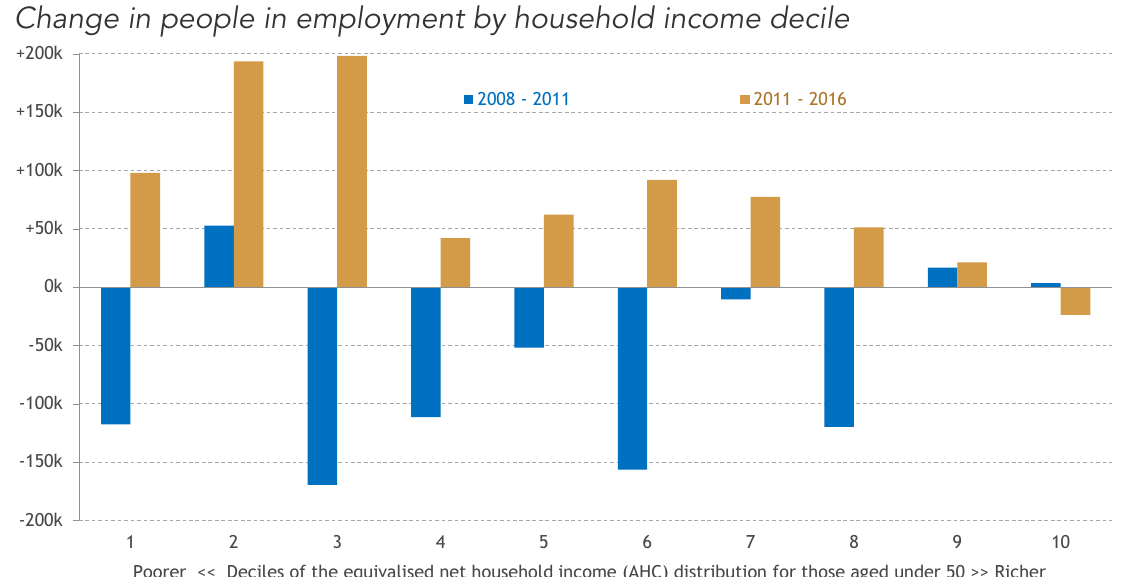
Figure 13: Employment gains since 2011 for those aged under 50 have been concentrated towards the bottom of the income distribution Change in people in employment by household income